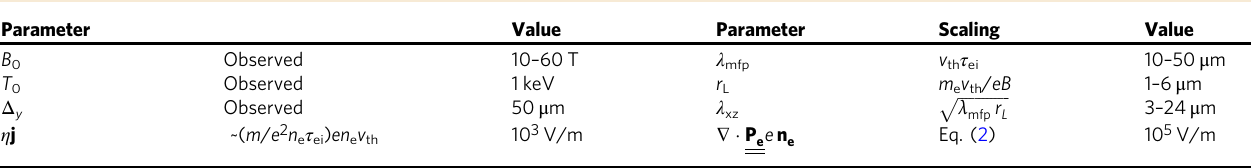
Relevant parameters to calculate the contributions to the terms of Ohm ’ s law, as extracted from experimental